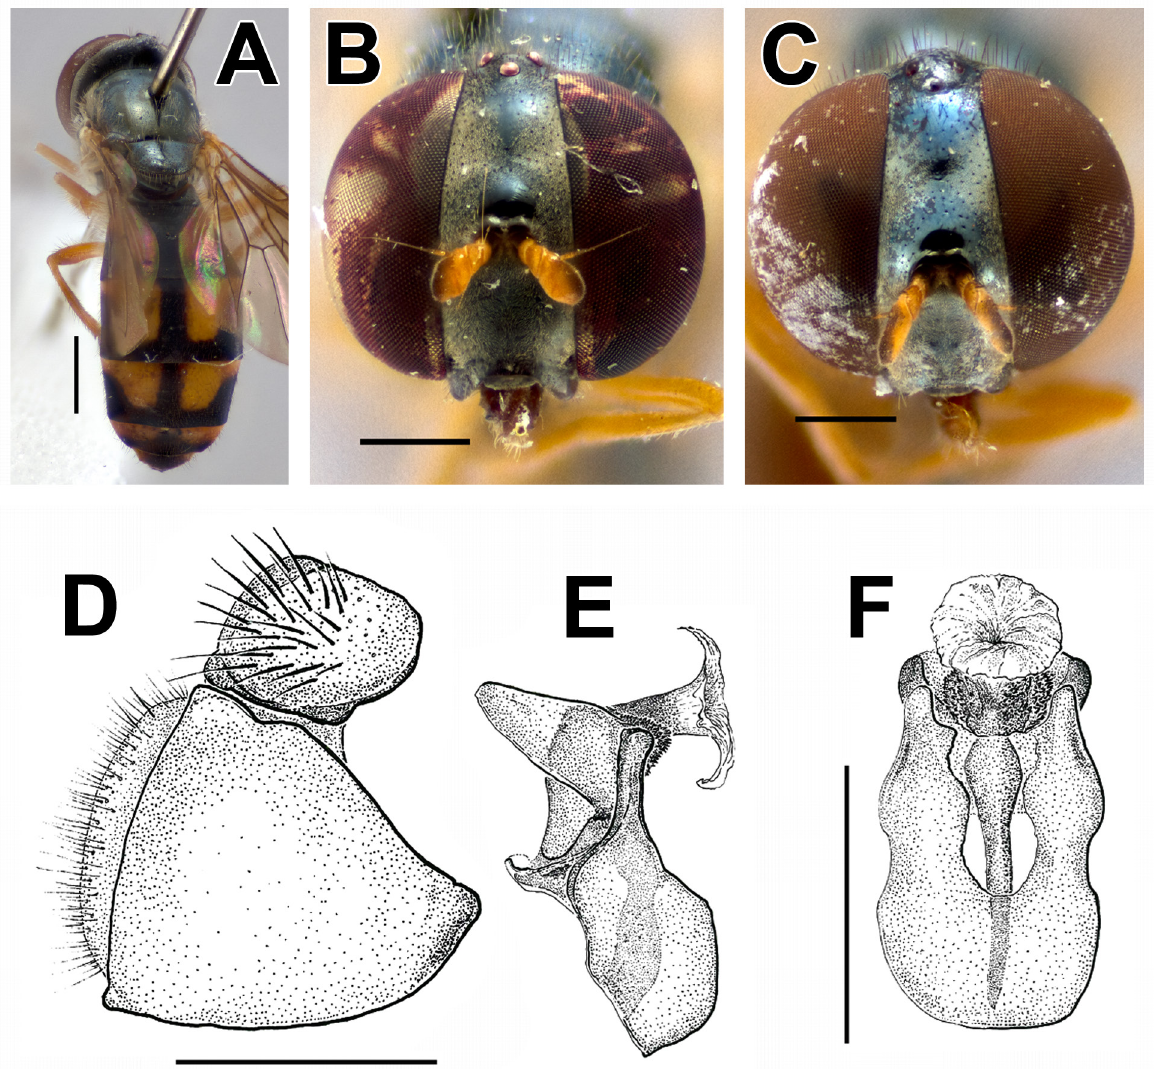
Fig. 8. A, C . Melanostoma apicale Bigot, 1884, ♀ (ZFMK-DIP-00019781). A. Posterior view. C. Head, frontal view. B . Melanostoma univittatum (Wiedemann, 1824), ♀ (ZFMK-DIP-00019740), head, frontal view. D–F . Allograpta jacqui Mengual & Ramage sp. nov., holotype, ♂ (ZFMK-DIP-00019707), genitalia. D. Epandrium with surstylus and cercus, lateral view. E. Hypandrium, lateral view. F. Hypandrium, ventral view. Scale bars: A–C = 1 mm; D–F = 0.5